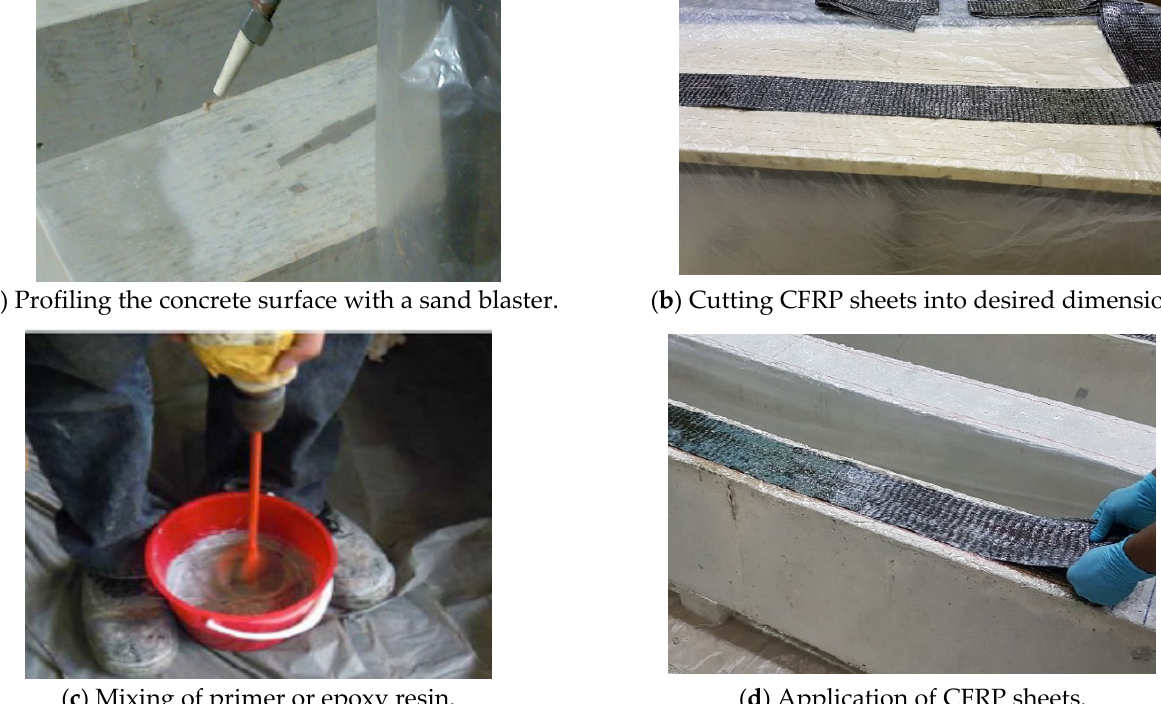
Figure 3. FRP-strengthening procedure for the tested beams.